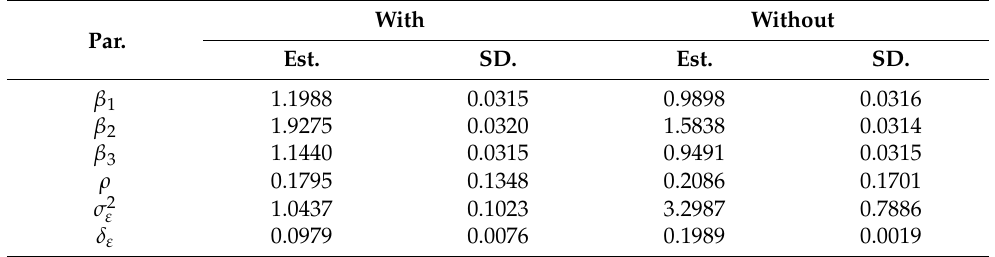
Table 2. Bayesian estimation with or without influence point 1 and 12 in the real example. With Without Par. Est. SD. Est. SD. β 1 1.1988 0.0315 0.9898 0.0316 β 2 1.9275 0.0320